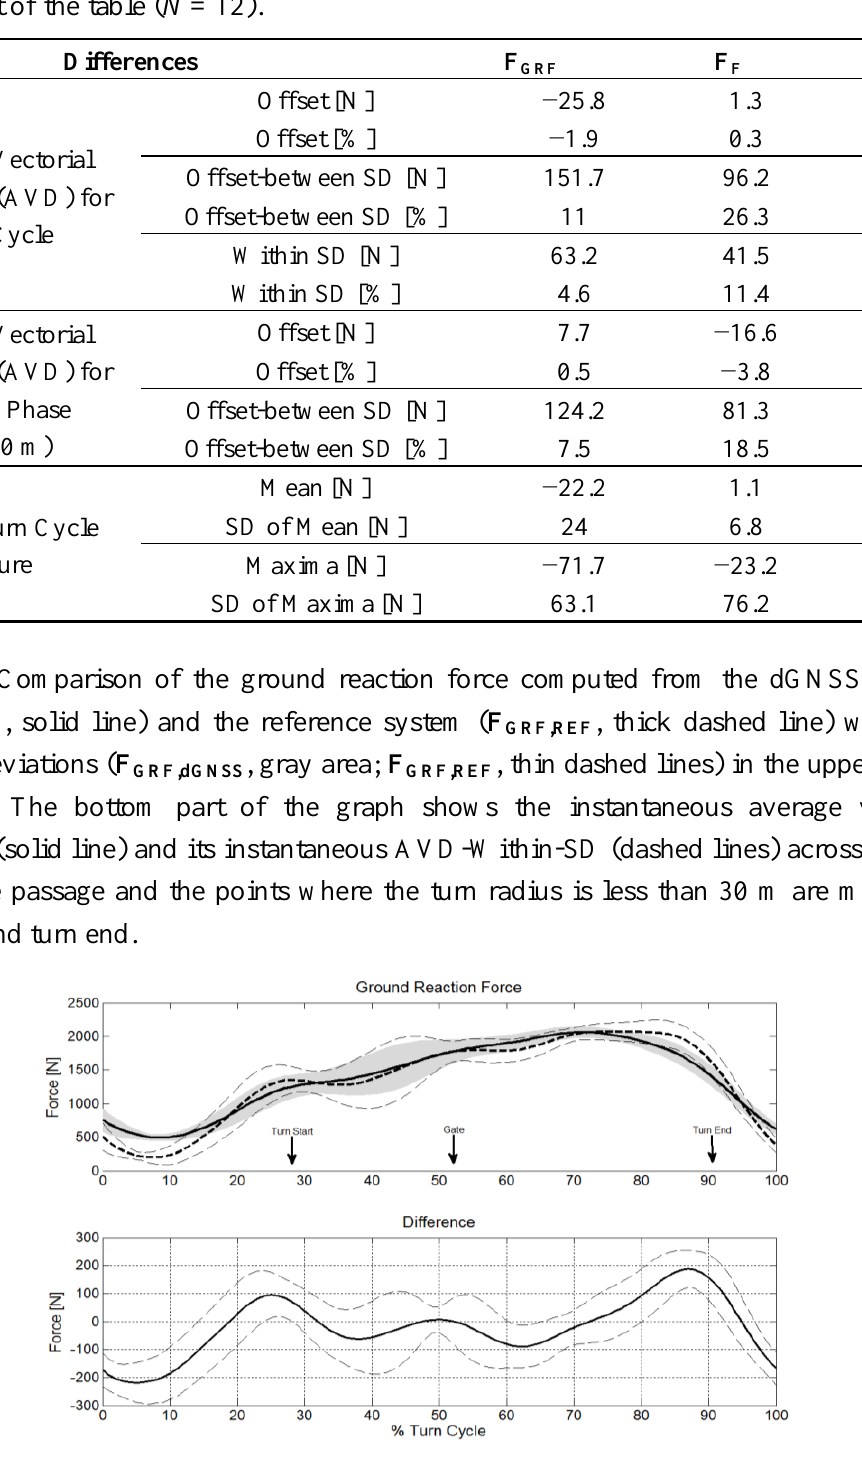
), ski-snow friction ( F ) and air GRF F